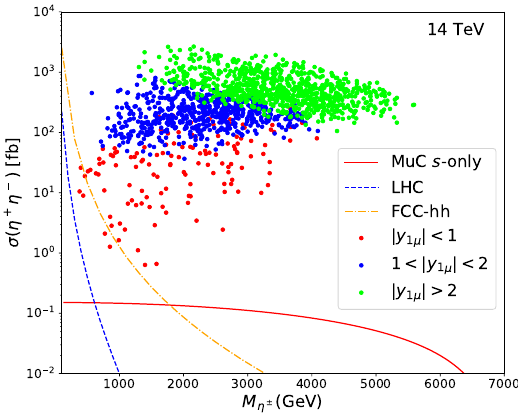
Figure 5 . The production cross-section of µ + µ − → η + η − at 14 TeV MuC. The red solid line is the cross-section at MuC with s -channel contribution only. The blue dashed (yellow dash-dotted) line corresponds to cross-section at 14 TeV LHC (100 TeV FCC-hh).